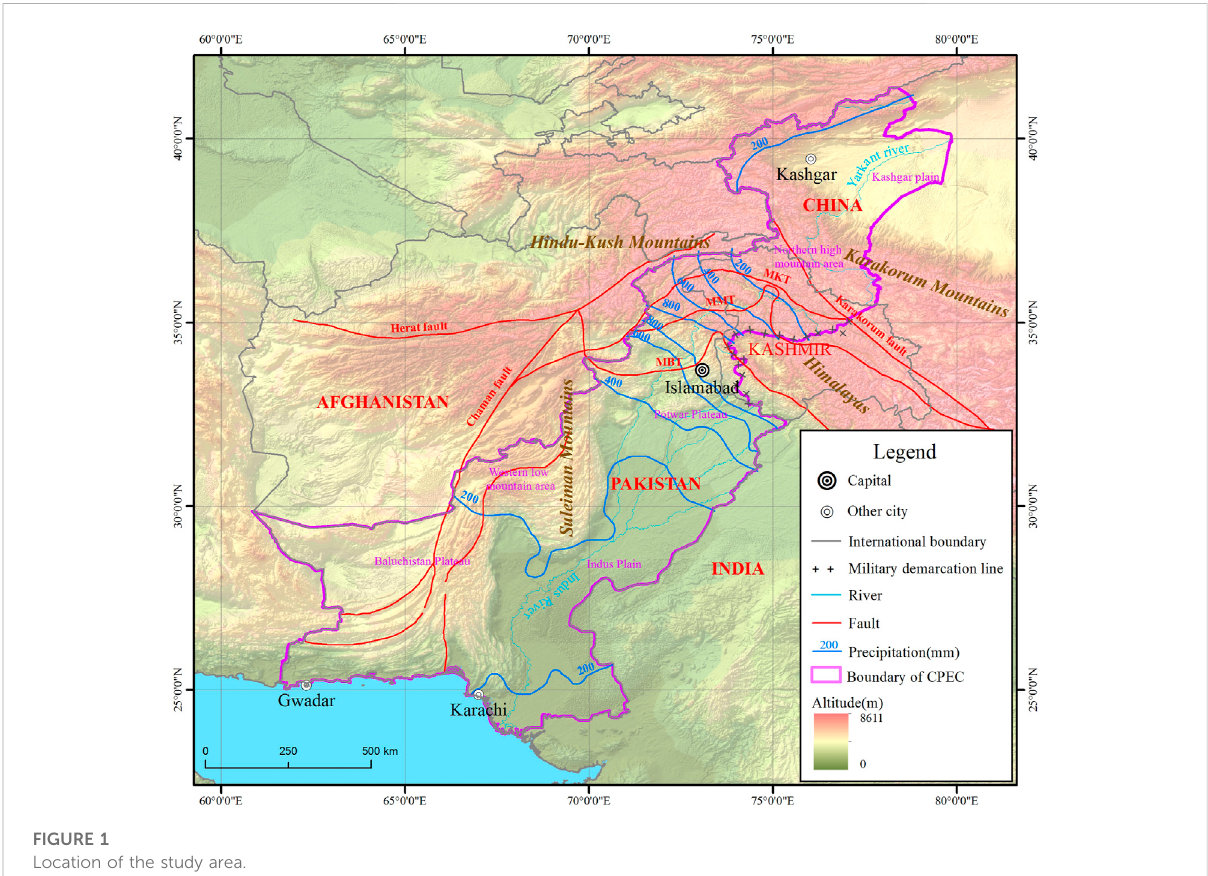
FIGURE 1 Location of the study